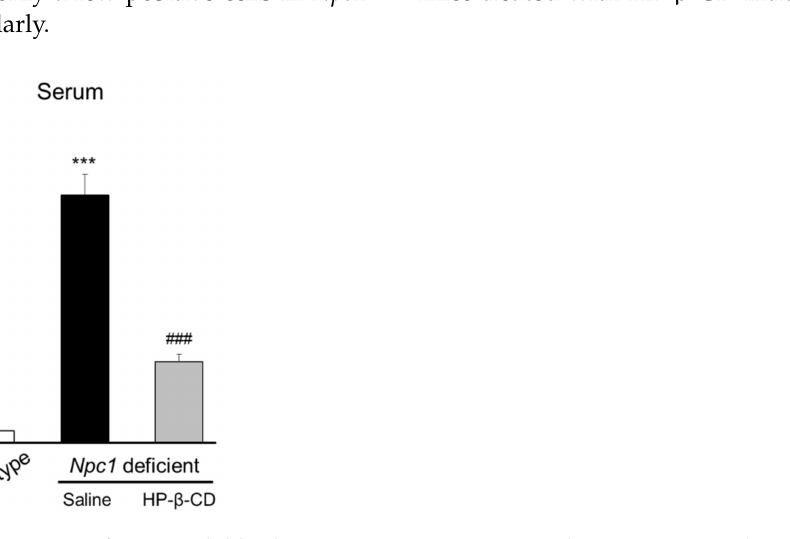
Figure 2. Suppression of serum soluble glycoprotein nonmetastatic melanoma protein B (sGPNMB) levels in Npc1 − / − mice treated with 2-hydroxypropyl- β -cyclodextrin (HP- β -CD) intracerebroven- tricularly. Levels of sGPNMB in mouse serum were assayed by ELISA. Data are presented as the mean ± S.E. ( n = 8–11). *** p < 0.001 compared with the wild-type group. ### p < 0.001 compared with the saline group.